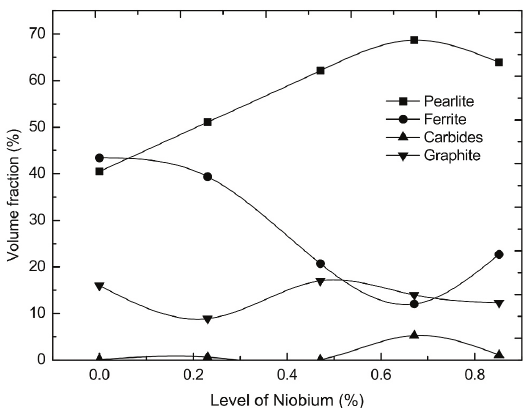
Figure 2. Variation of the volume fractions of pearlite, ferrite, carbides and graphite in NCIs for various Niobium contents.